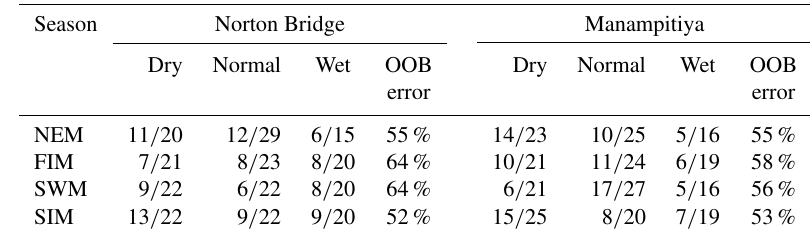
Figure 4. Norton Bridge and Manampitiya rainfall classes (dry, average, wet) identified by ENSO and IOD phenomena. (a) Norton Bridge SWM rainfall classification tree model, (b) Manampitiya NEM rainfall classification tree model, (c) Norton Bridge SWM rainfall QDA, and (d) Manampitiya NEM rainfall classification by QDA. Table 3. Results of random forest ensemble classification results. Out-of-bag error (OOB) is the classification error calculated from the data not used to fit the tree.